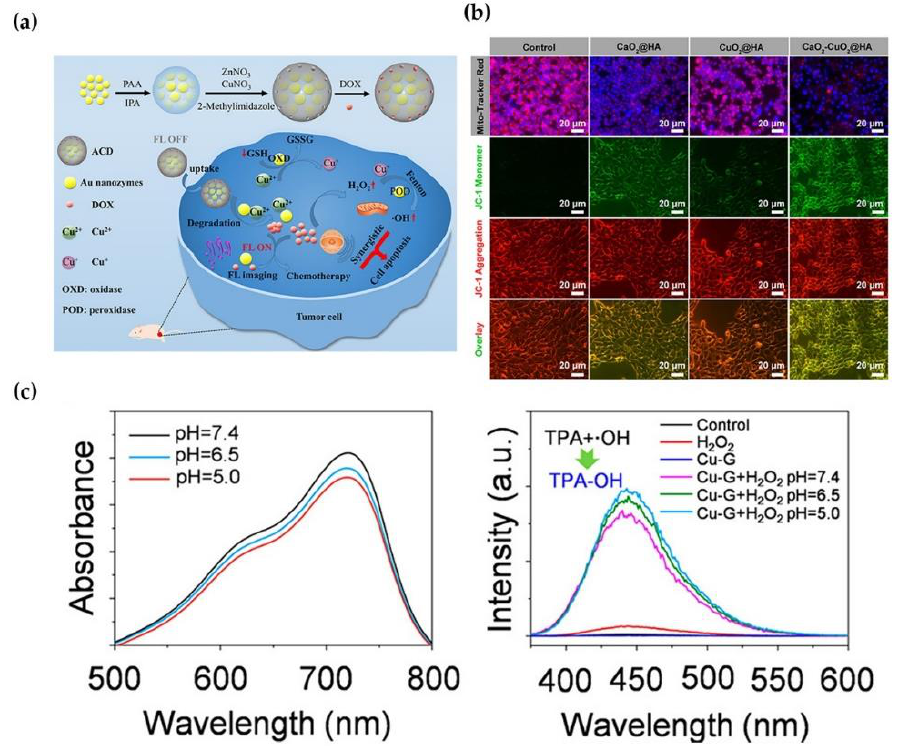
Figure 6. ( a ) Copper ions enhance CDT by depletion of GSH. ( b ) Cell apoptosis ratio of Cu 2+ compared to Ca 2+ in 4T1 cells. ( c ) Copper NP complex reacts quickly in slightly acidic TME. Reprinted with permission from Refs. ( a ) [77] 2021 American Chemical Society, ( b ) [76] 2022 American Chemical Society] and ( c ) [72] 2019 American Chemical Society.